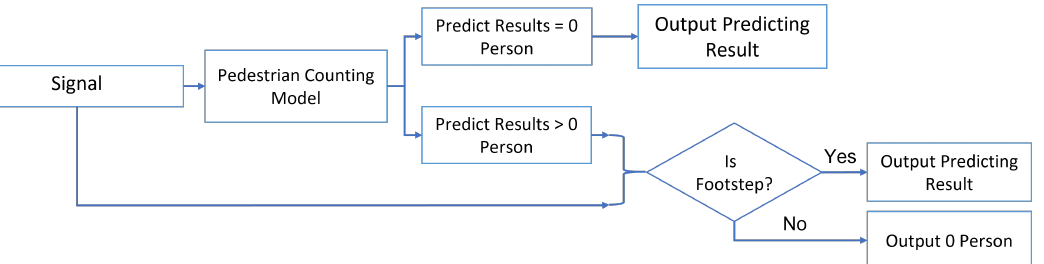
Figure 5. The logic about making prediction for the system. If the system predicts that there is more than one person in the area due to a vibration event detected, it will further check that the signal/vibration event is caused by footsteps. If it is, the system outputs the results. Otherwise, the system outputs 0 person as a result.